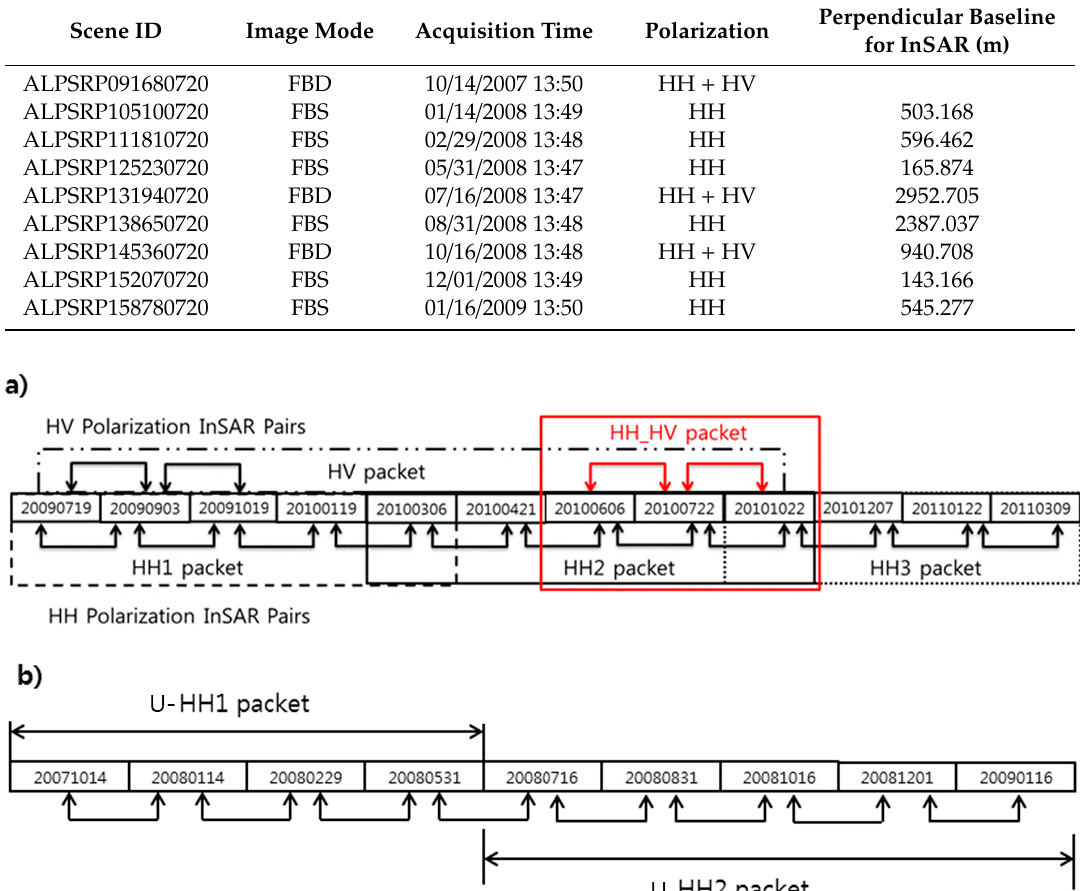
Table 2. InSAR image information over Uljin test area.